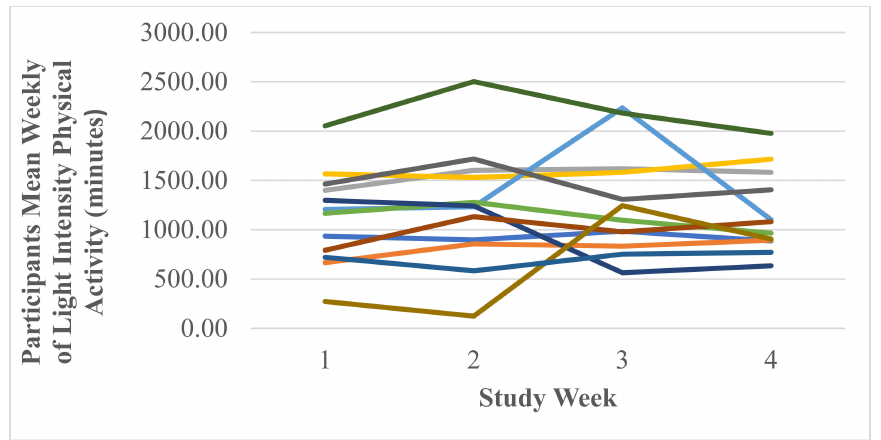
Figure 7. Individual participants’ mean weekly minutes of light intensity physical activity (each coloured line represents one of the 12